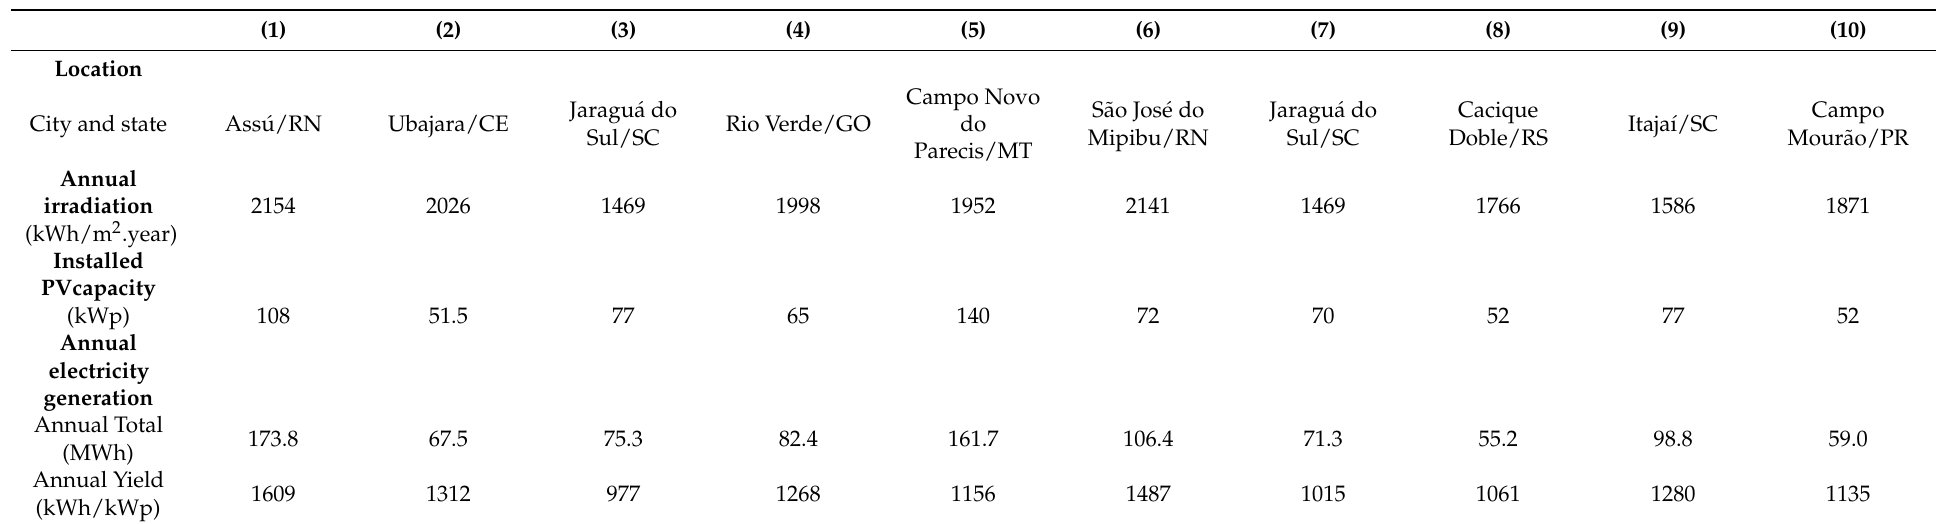
Table 2. Technical specifications of the evaluated photovoltaic